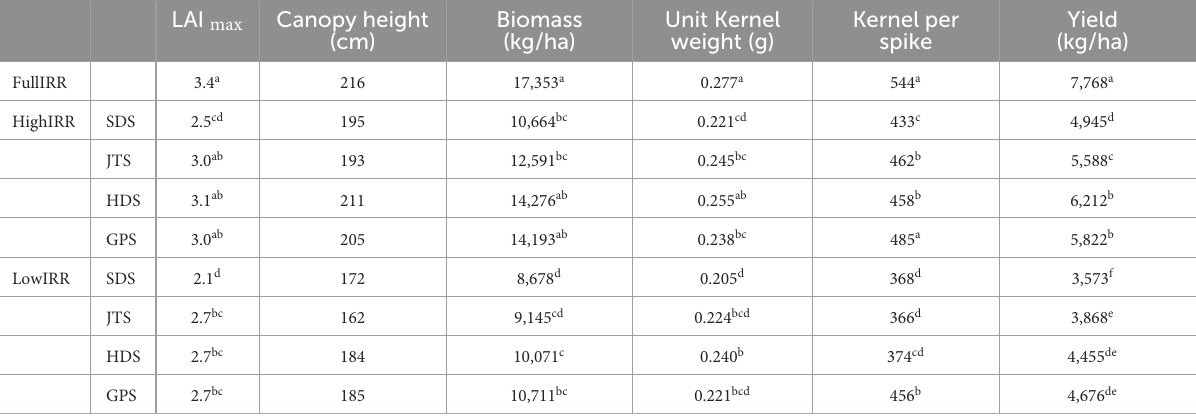
FIGURE3 Maize yield response to precipitation anomaly from simulations of 12 global crop models participated in the AgMIP (green solid line and shaded area) compared with the observed response (black solid line). The green solid line shows the multi-model median response and the shaded area shows the model’s interquartile range. The AgMIP global crop model data are from the historical simulations of 1981 to 2010 without irrigation, driven by AgMERRA with the default setting. Adapted from Li et al. (2019b).